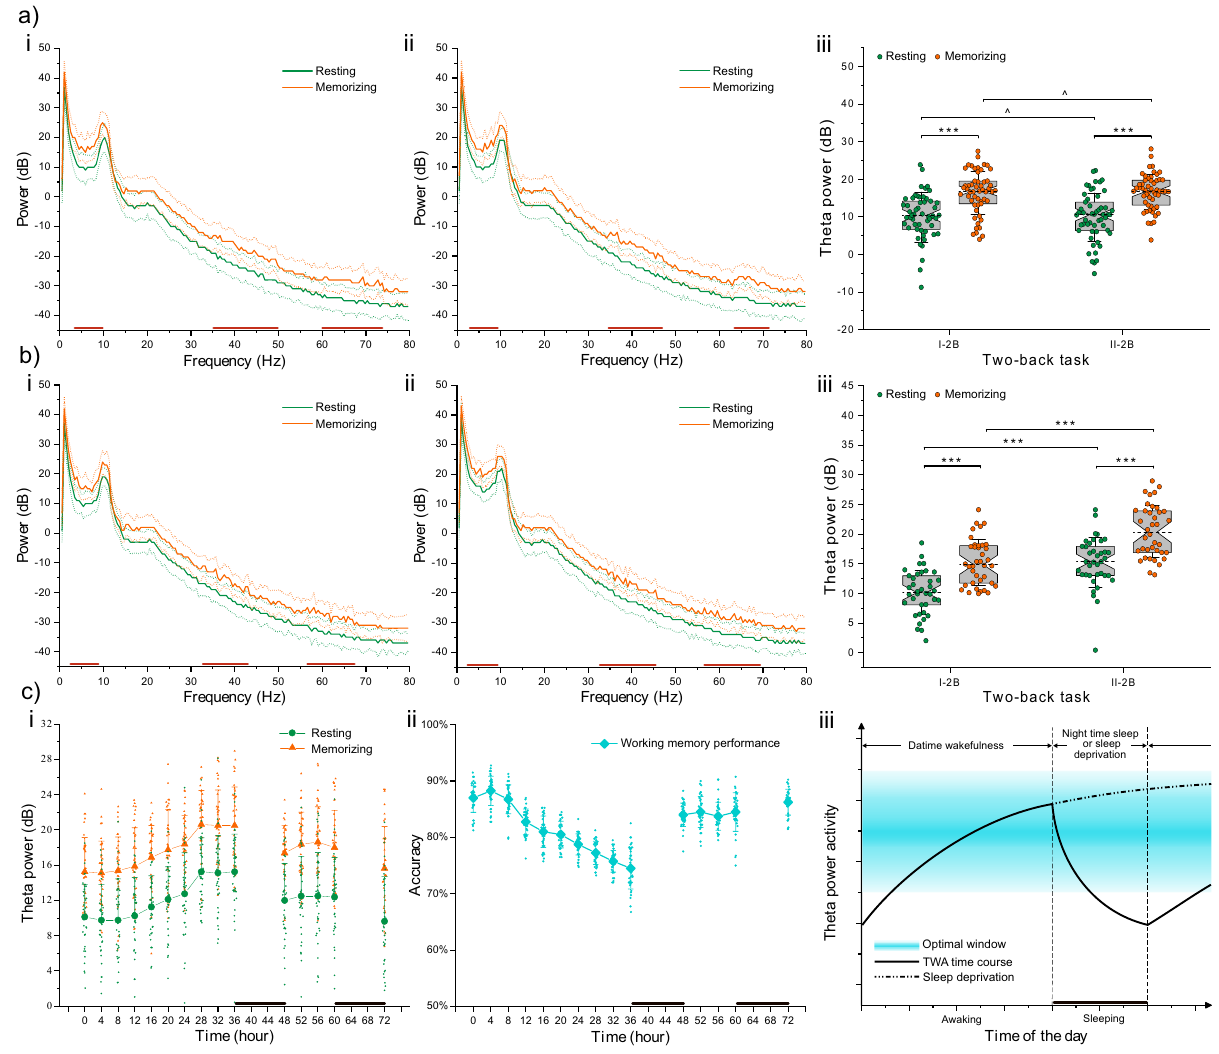
Fig. 4 Analyses of the theta wave activity. a n = 54, (i) and (ii) panel show the electroencephalographic (EEG) spectral power before and after the lengthy mental task, respectively. Solid lines represent means. Dashed lines represent 95% con fi dence intervals. Paired-sample t -tests of two-tailed were used to reveal statistical differences for all frequency ranges by the 1 Hz step. Theta power density in the 4 – 8 Hz frequency range of memorizing condition was signi fi cantly higher than that of the resting condition. For the frontal-central cortex (FCC) surface, (iii) panel shows the averaged theta wave activity (TWA) in the resting (green dots) and memorizing (orange dots) conditions. After the lengthy mental task, TWA in FCC surface was not signi fi cantly different (^ p > 0.05). The whisker threads in both ends of the boxplot represent standard deviations, and dashed lines in the middle of the boxplot represent medians. b n = 38, i and ii panel show the EEG spectral power before and after sleep deprivation of 36 h, respectively. Solid lines represent means, and dashed lines represent 95% con fi dence intervals. Theta power density in the 4 – 8 Hz frequency range of memorizing condition was signi fi cantly higher than that of the resting condition. (iii) Panel shows the averaged resting (green dots) and memorizing (orange dots) TWA in FCC surface. After the sleep deprivation, TWA in FCC surface was signi fi cantly higher (*** p < 0.0001). The whisker threads in both ends of the boxplot represent standard deviations, and dashed lines in the middle of the boxplot represent medians. c n = 38, (i) panel shows the TWA change curve with the sleep deprivation and recovery time course. Green and orange dots represent resting and memorizing conditions, respectively. Data is shown by means + standard deviations. (ii) Panel shows the behav i or performance curve with the sleep deprivation and recovery time course. Data is shown by means + standard deviations in cyan rhombus. (iii) Panel depicts the proposed interplay between the time course of TWA (sleep-dependent homeostatic: solid and dotted lines) and the behavior performance of working memory (cyan window). Wakefulness is associated with an upscaling, while sleep is associated with a downscaling of TWA. Sleep deprivation eventually leads to TWA saturation and a behavioral obstacle to working memory. (Supplementary Fig. 2b, c), providing the evidence for dissociat- increased signi fi cantly (Resting: T 37 = − 2.45, p = 0.0192; Mem- ing abnormal oscillation mechanisms caused by the lengthy orizing: T 37 = − 2.37, p = 0.0229) from 20 h compared to that at a baseline of 0 h. This upward trend lasted until 36 h, which con- mental task or sleep deprivation. fi rmed that TWA was continuously increased at later stages of sleep deprivation, despite nearly saturated growth in the last Sleep deprivation gradually impeded the sleep-dependent hours of the sleep-deprived period. Interestingly, beginning soon recovery mechanism of TWA in the FCC surface . Over time after the fi rst sleep recovery of 12 h, theta power was reduced (Fig. 4c), the change curve for theta power density began to shift compared with the highest density that was observed during the upward after ~16 h of continuous wakefulness of participants and COMMUNICATIONS BIOLOGY|